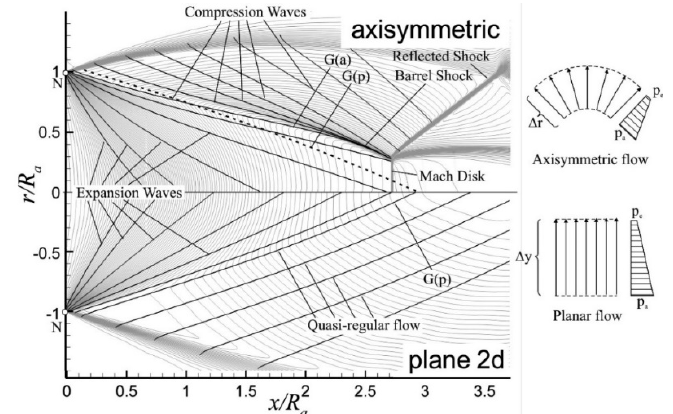
Figure 12. Comparison between the flow structure of the axisymmetric jet ( top ) and that of the plane sonic jet ( bottom ) for M a = 1 and n = 2.64.